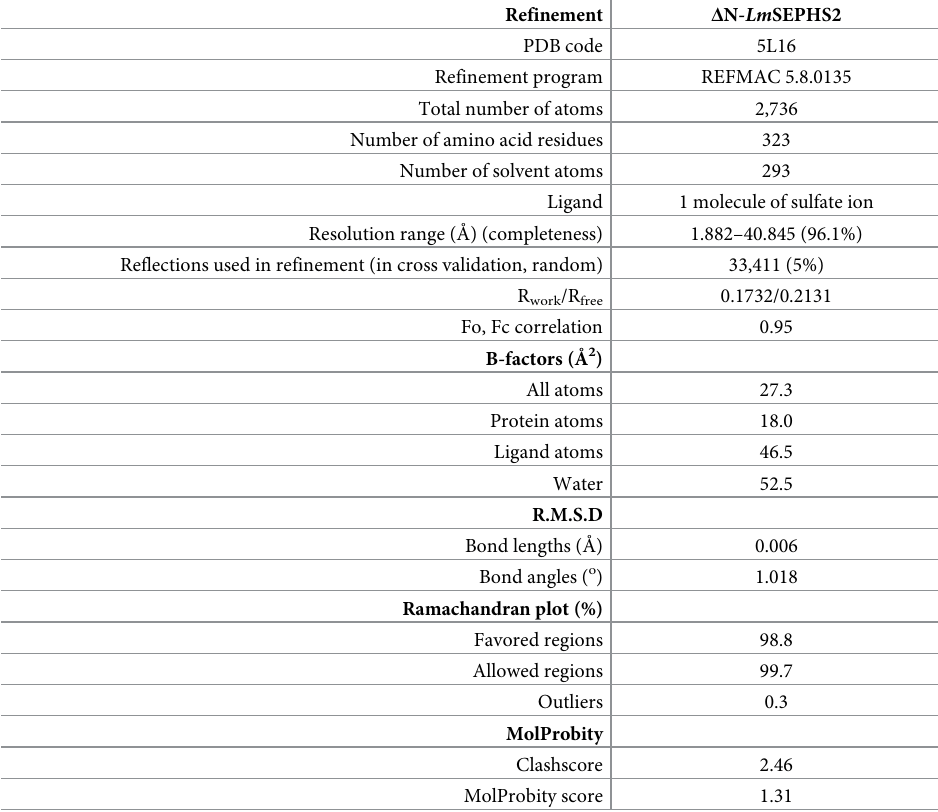
Table 1. Δ N- Lm SEPHS2crystal structure refinement